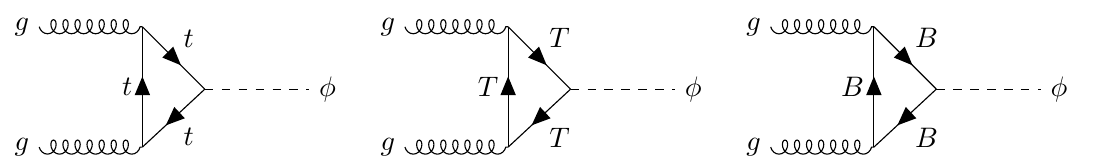
Figure 5. Dominant Yukon φ production modes at the LHC.